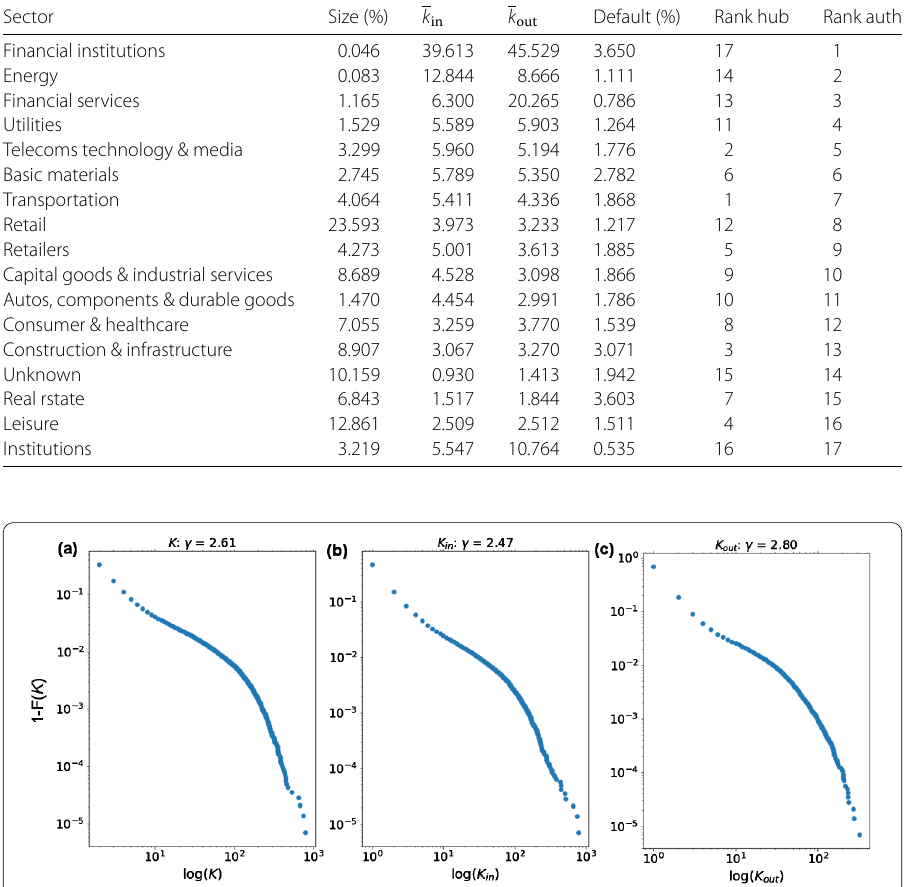
Table 1 Summary of network topological measures by sector where k in and k out stand for the average in-degree and out-degree, respectively Sector Size (%) k in k out Default (%) Rank hub Rank auth Financial institutions